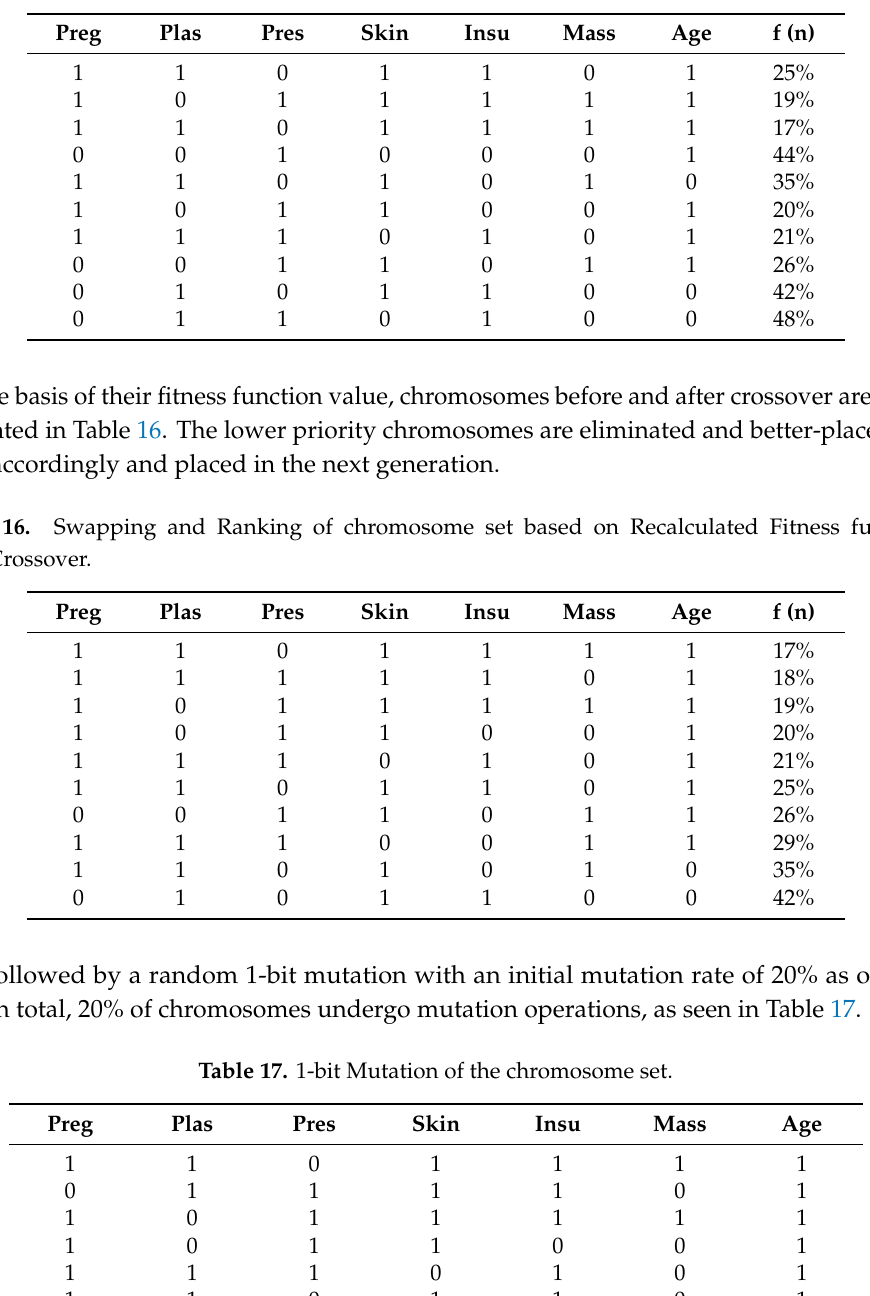
Table 15. Recalculation of Fitness function after Crossover on the chromosome set.